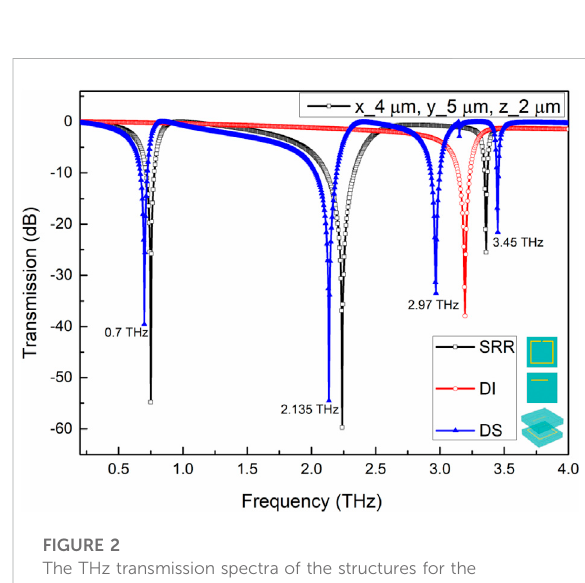
FIGURE 2 The THz transmission spectra of the structures for the proposed